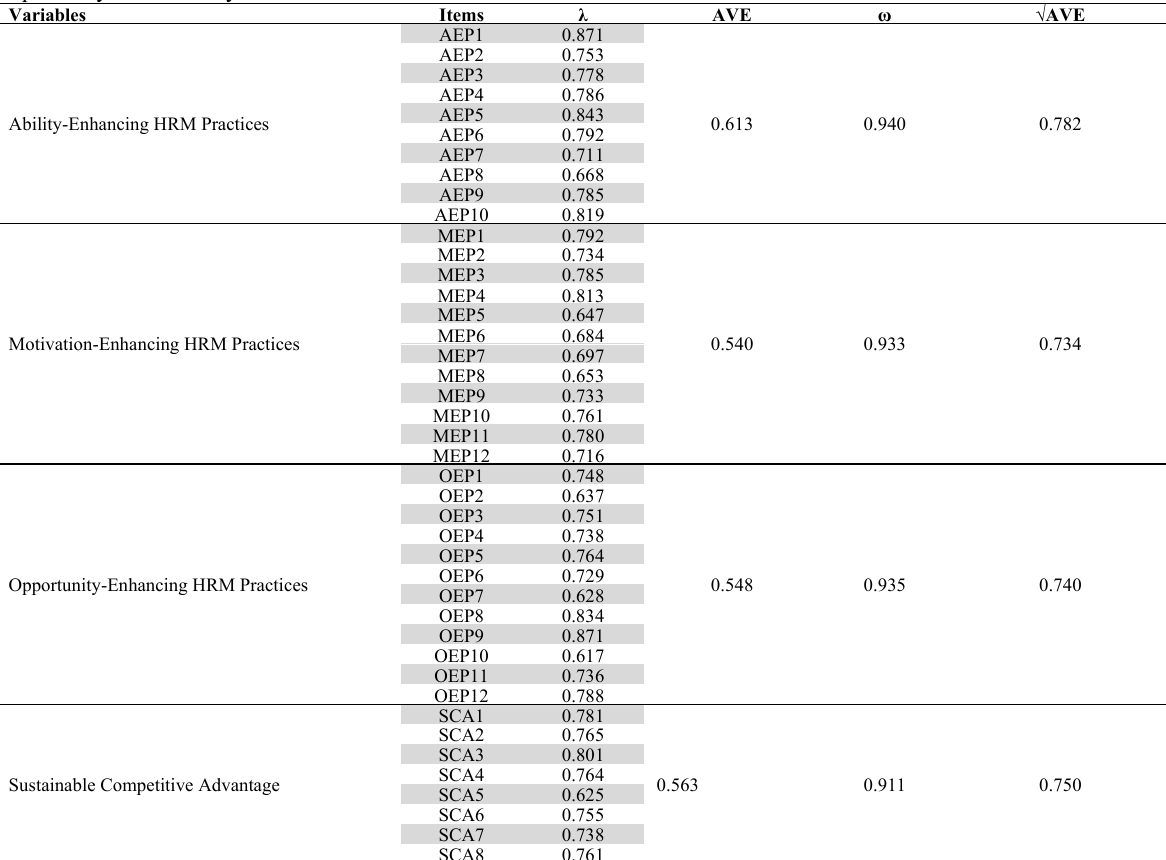
Exploratory Factor Analysis